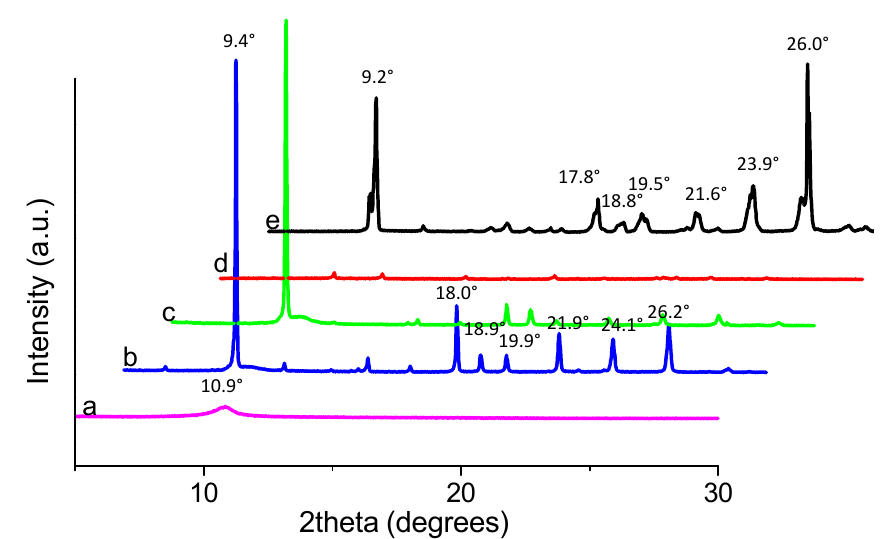
Figure 9. X-ray diffraction (XRD) spectra of ( a ) GO, ( b – d ) PBD:GO blends with 2:1, 5:1, 10:1 (w/w), Figure 9. X ‐ ray diffraction (XRD) spectra of ( a ) GO, ( b ‐ d ) PBD:GO blends with 2:1, 5:1, 10:1 (w/w), respectively, and ( e ) respectively, and ( e ) PBD.